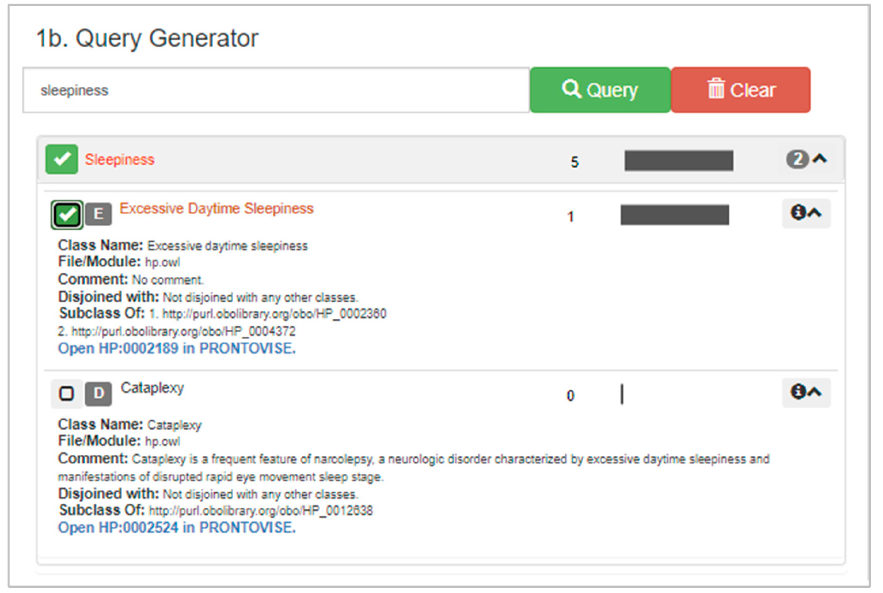
Figure 7. Expanding a query item to assess related ontology elements.